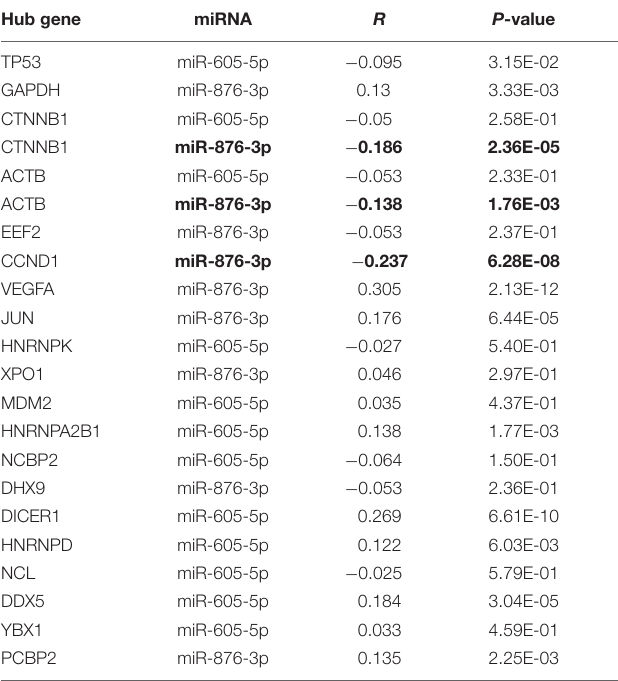
TABLE 4 | The expression correlation between miRNA and hub gene in thyroid carcinoma determined by the starBase database. Hub